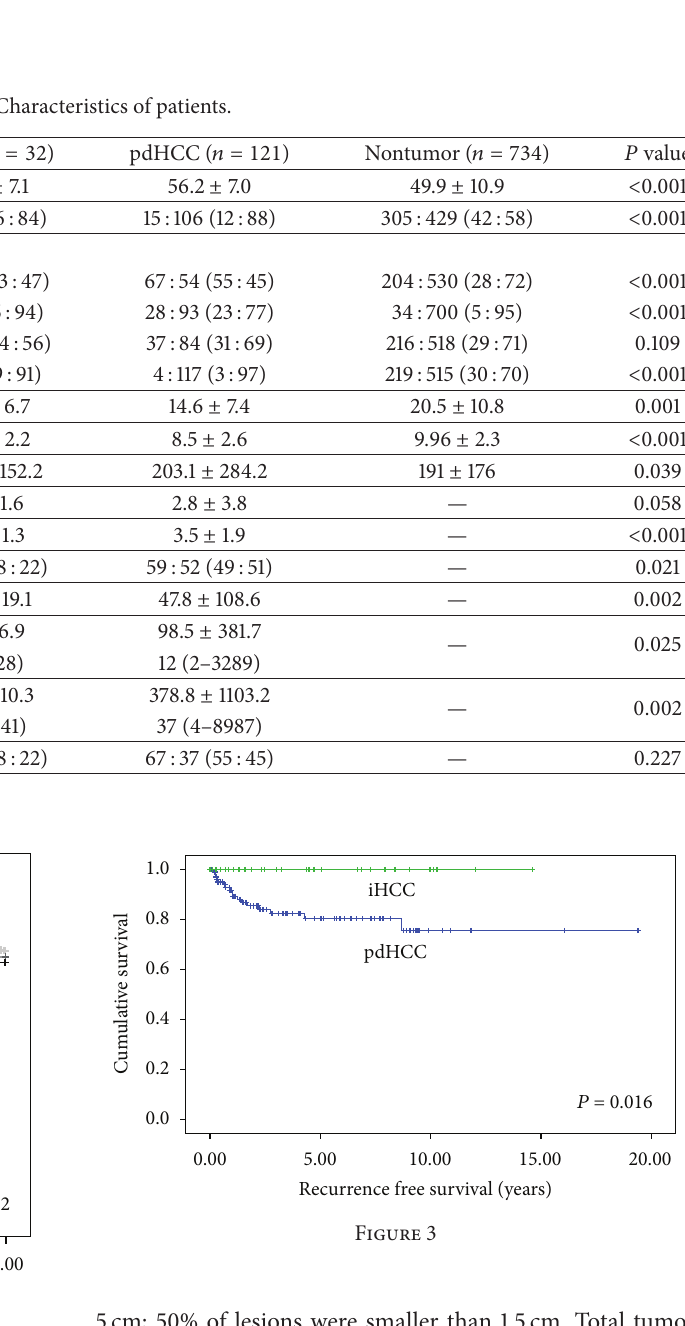
5 cm; 50% of lesions were smaller than 1.5 cm. Total tumor volume ranged from 0.1 to 66.3 cc 3 with 50% of